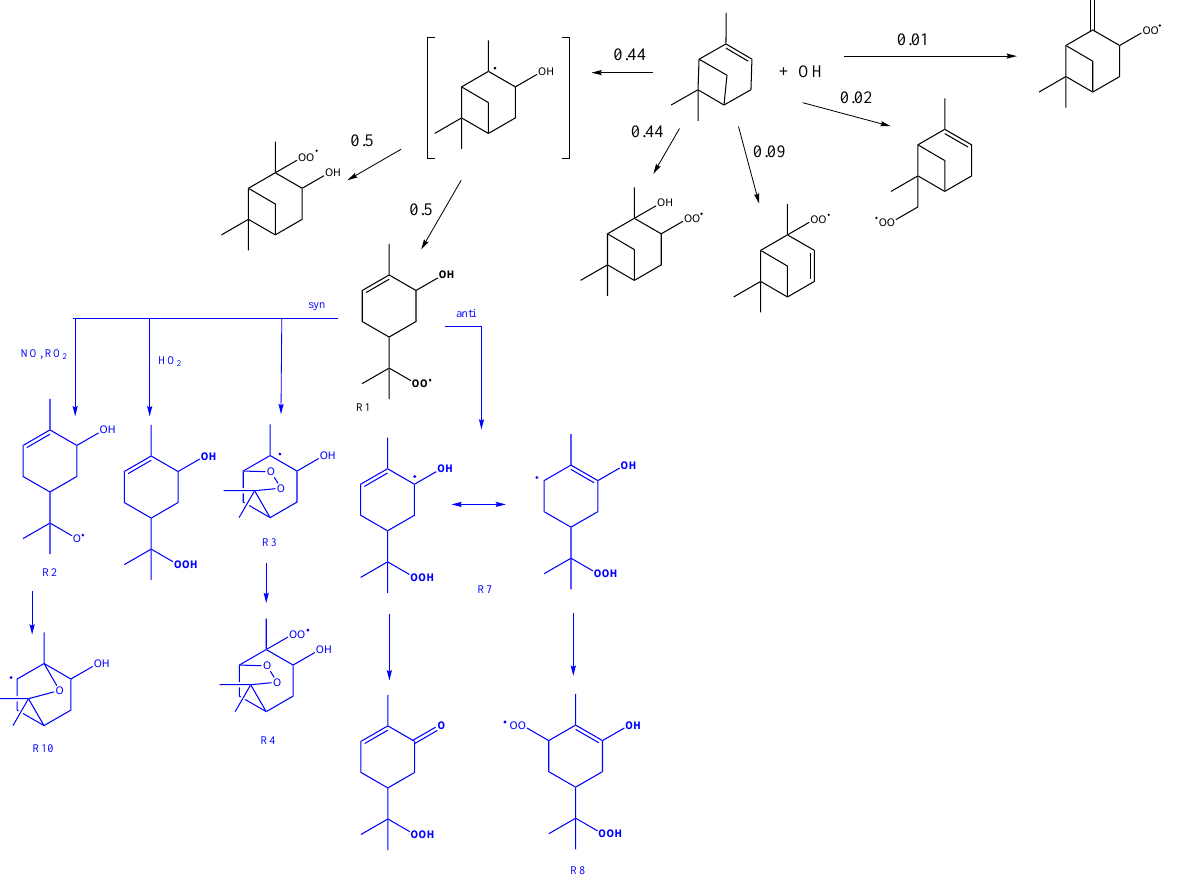
Figure 1. Overview of the α -pinene + OH oxidation mechanism in GECKO-A. Reactions in black are those originally implemented in Valorso et al. (2011). Additions to this mechanism are shown in blue. Species are labeled to be consistent with Vereecken et al. (2007). All subsequent chemistry is generated in GECKO-A according to the standard protocols in